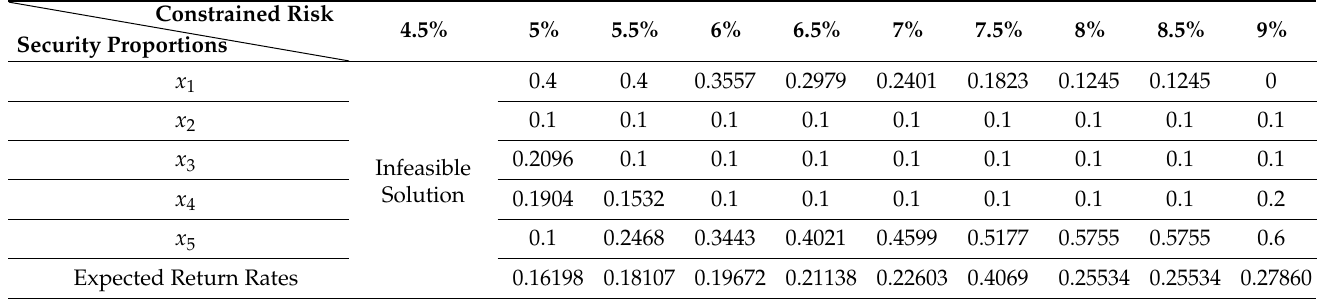
Table 1. The dimension with t = 2, and s = 1 with a guaranteed return rate (cid:101) p 1 in the proposed model. ProportionsConstrained Security